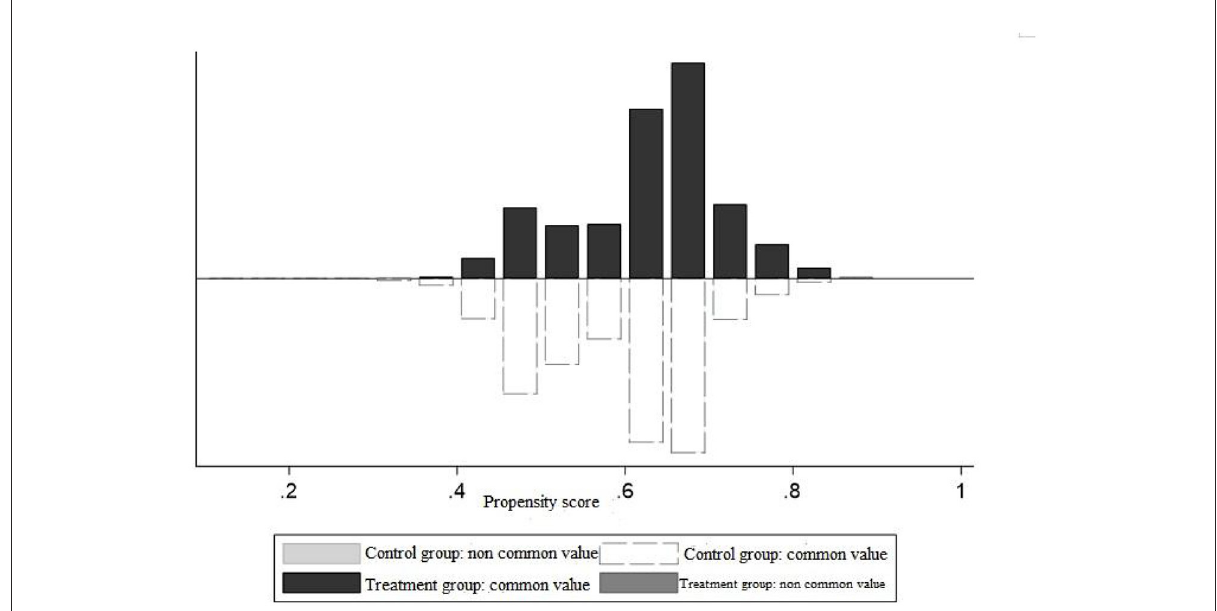
FIGURE4 Common range of propensity scores.